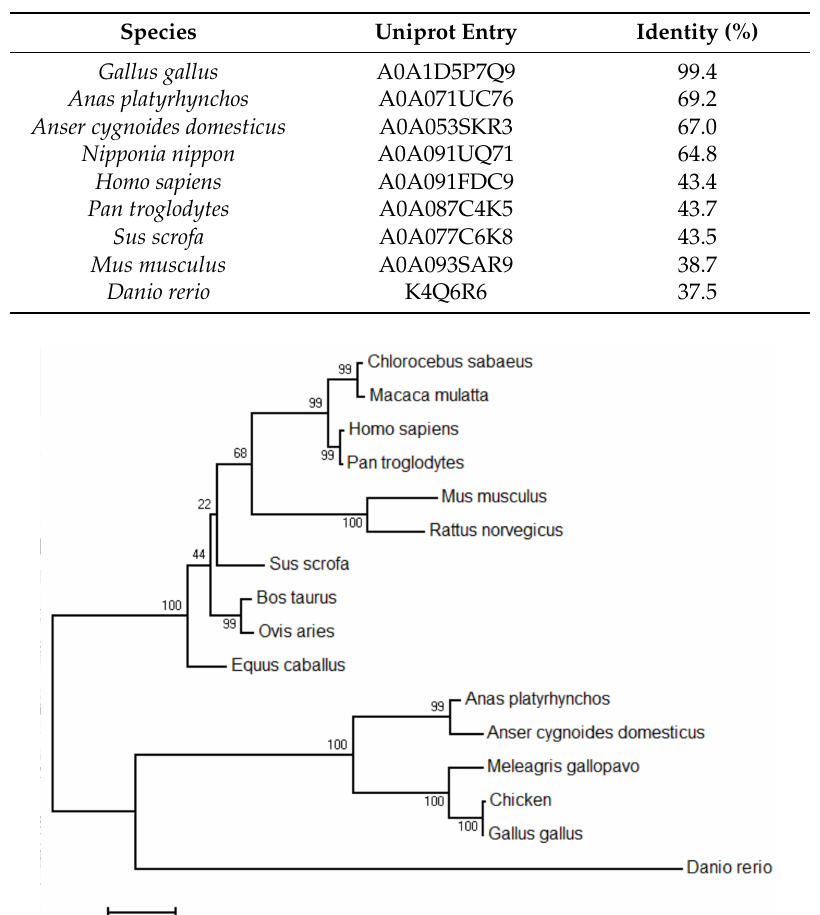
Table 2. The similarity of predicted chicken STING protein with other species.